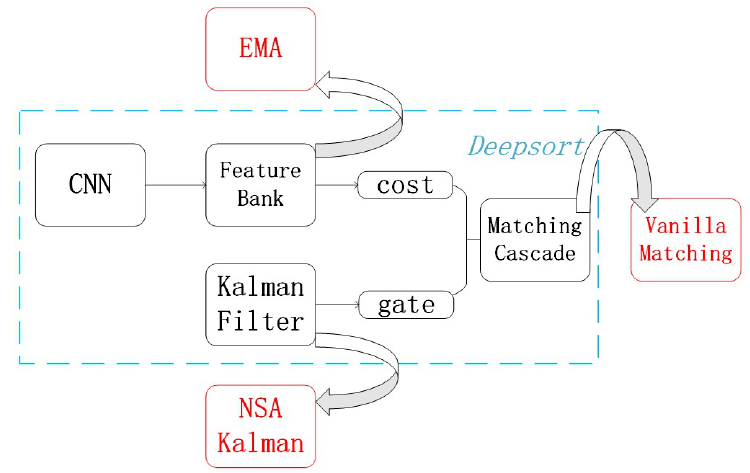
Figure 4. Deepsort Improvement Strategy